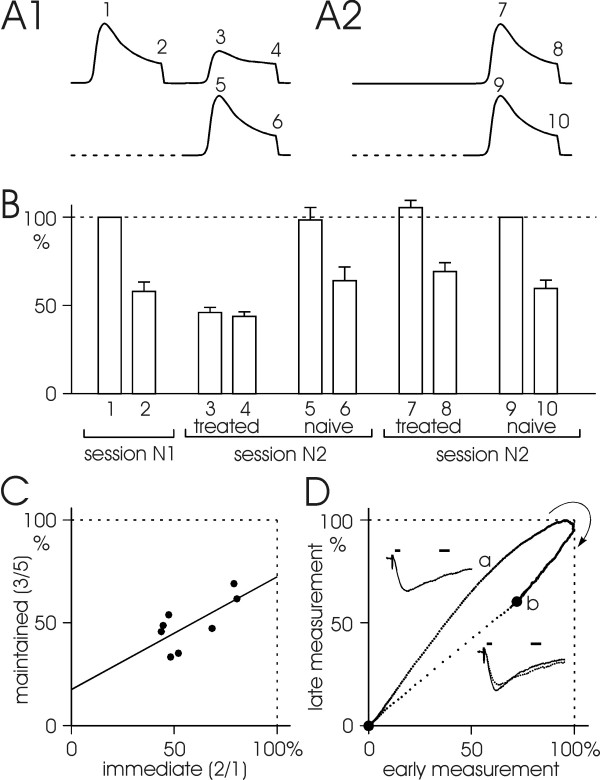
Summary of NMDA EPSP depressions during unblocking of NMDA receptors. (A1) Schematic representation of the experiment described in Fig. 1. (A2) Schematic representation of the experiment described in Fig. 2. Pathways are defined as "treated" or "naive" depending on whether stimulation was "on" (solid) or "off" (dashed) during session N1. Each number (1–10) in A1 and A2 represents a portion where measurements were taken for analysis. (B) Comparison between NMDA EPSP measurements, each bar representing an average obtained for 30 consecutive responses (5 min). Value no. 1 was chosen as 100 % for experiments depicted in A1. Since a corresponding value was lacking for experiments depicted in A2, value no. 9 was chosen as 100 %. All values are expressed as mean and S.E.M (n = 8 and n = 5, respectively, for A1 and A2 type experiments). (C) Relation between instantaneous depression in session N1 (abscissa, final value relative to peak) and persistent depression in session N2 (ordinate, interpathway comparison of peaks). Each dot represents a single experiment. The analysis revealed a significant correlation between the variables as illustrated by the superimposed regression line (n = 8). (D) Relation between early and late measurements obtained with two different time windows (initial 5 ms and 35–45 ms, respectively) plotted as a "phase trajectory" (abscissa, early measure; ordinate, late measure). The curve represents an average of 20 experiments with additional smoothing to reduce noise (5 min moving average). Samples of recorded NMDA EPSPs corresponding to locations a, b of the trajectory are overlaid. Bars above EPSPs curves indicate time windows used for early and late measurements, respectively. The curve at b is shown superimposed on a dotted copy of the curve at a.